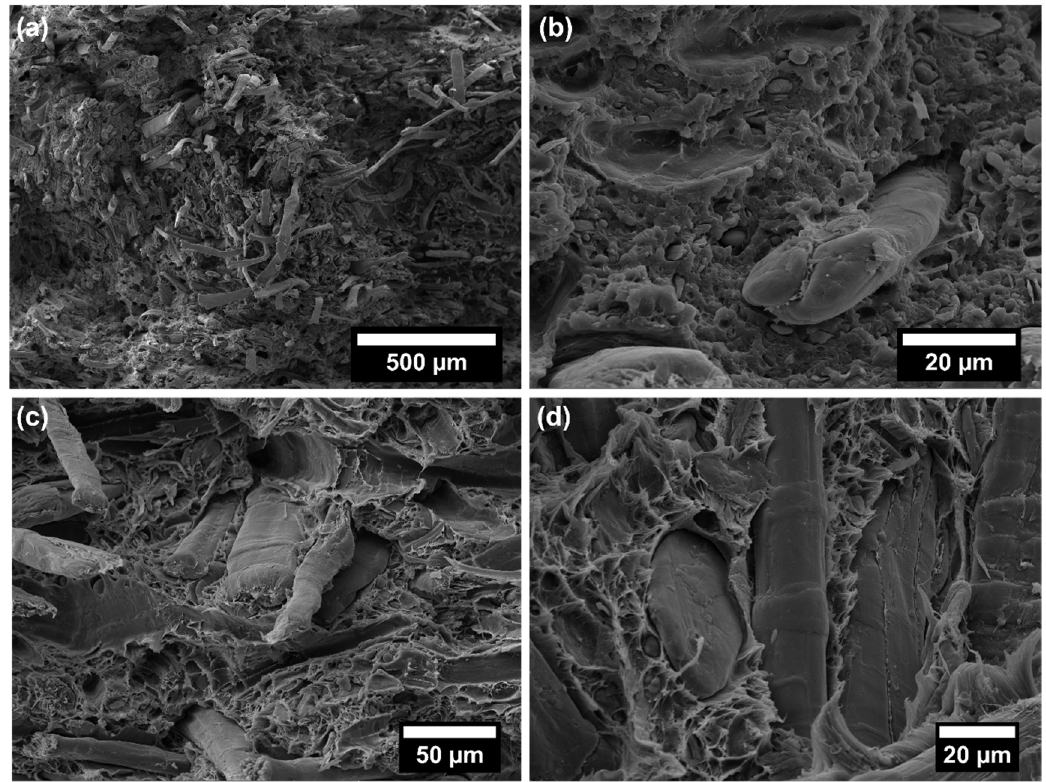
Figure 6. SEM micrographs of EcoAl_30F: ( a , b ) after tensile test; ( c , d ) after Charpy impact test.